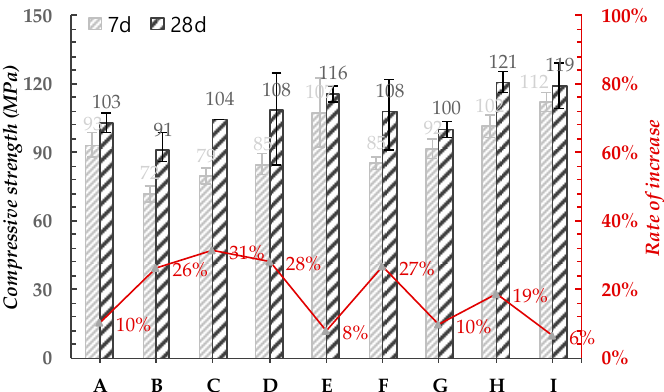
Figure 9. Compressive strength test result.